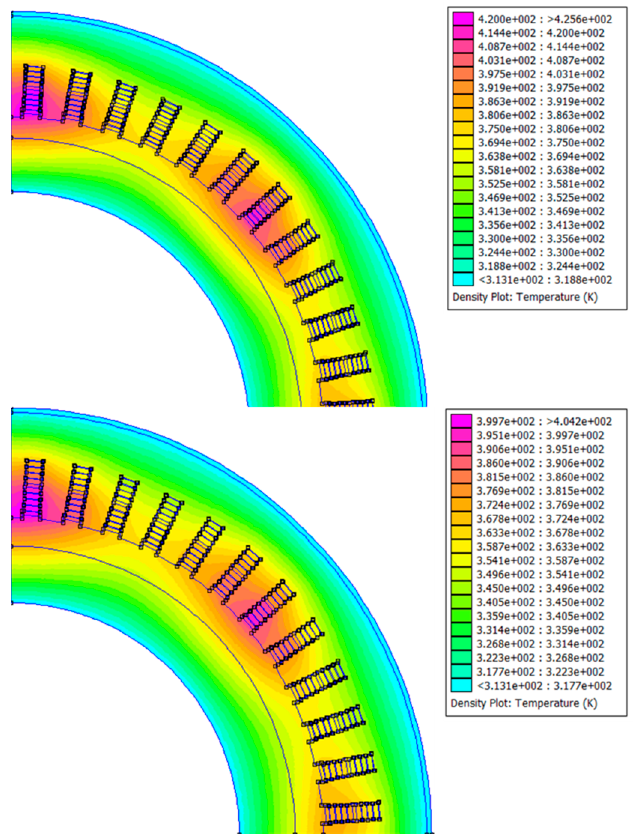
Figure 12. Temperature in the front end-windings of the best power density motor (upper figure) and best rated power motor ( lower figure ).